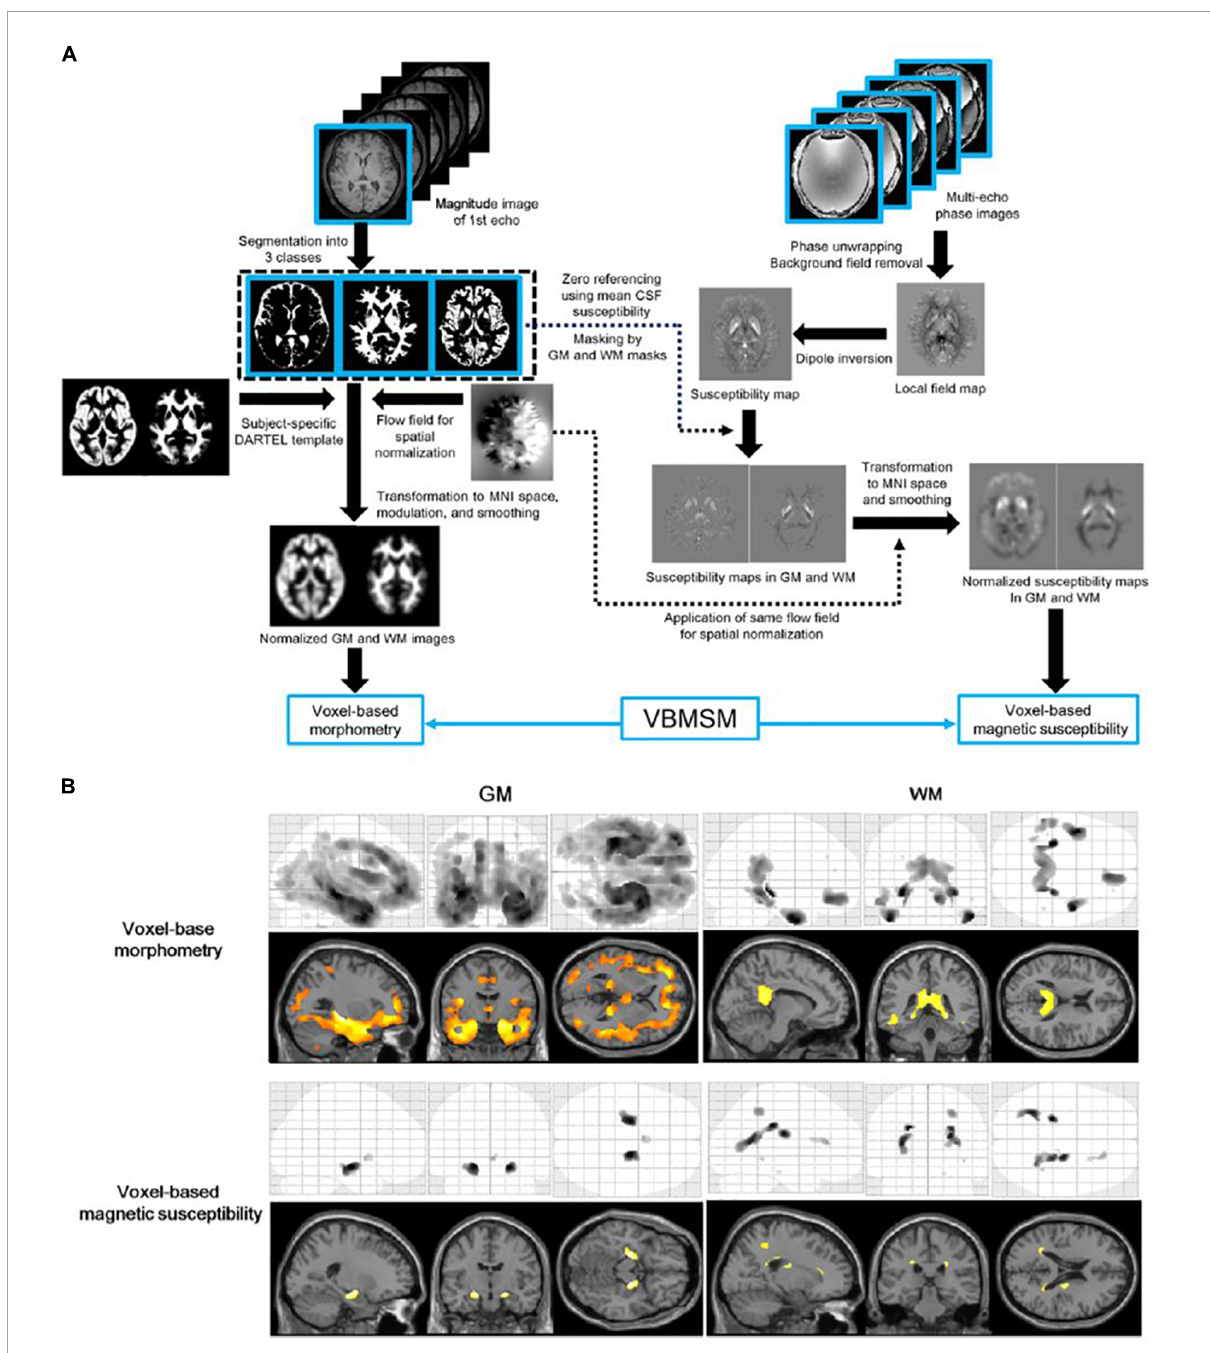
FIGURE2 Diagram of voxel-based morphometry and magnetic susceptibility analyses (A) and results of the voxel-based analyses (B) . The top of the left-hand panel shows the procedure of the voxel-based morphometry analysis. The top of the right-hand panel shows the procedures of the susceptibility estimation and spatial normalization of the map for the voxel-based magnetic susceptibility analysis. The bottom panel shows the results of voxel-based morphometry and magnetic susceptibility comparisons between elderly volunteers and patients with Alzheimer’s disease. A corrected P -value of < 0.05 with the family-wise error correction was applied as the threshold to detect regional volume decreases and susceptibility increases in the Alzheimer’s disease group. GM, gray matter; VBMSM, voxel-based magnetic susceptibility and morphometry; WM, white matter (adapted with permission from Kan et al.,